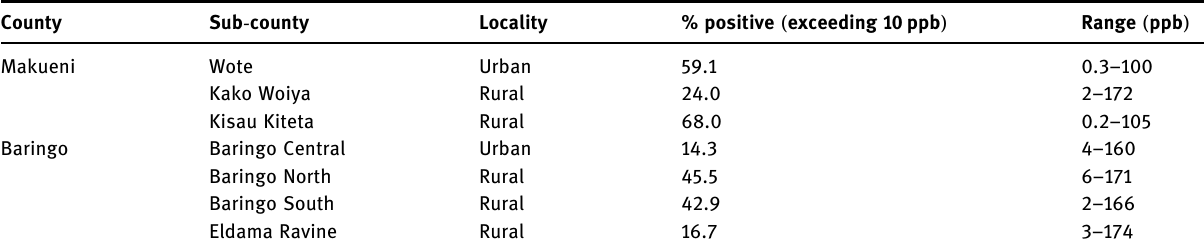
Table 1: Summary of mean total a fl atoxin levels of maize ( ELISA ) from Makueni and Baringo Counties County Sub - county